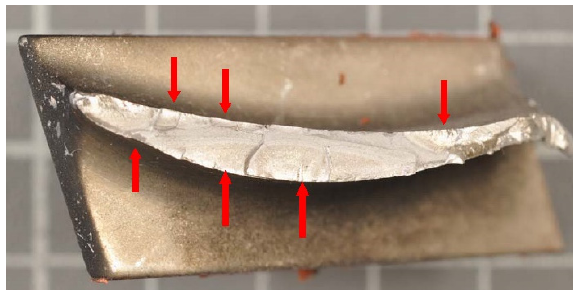
Figure 14. Fatigue failure locations of a compressor 5th blade.